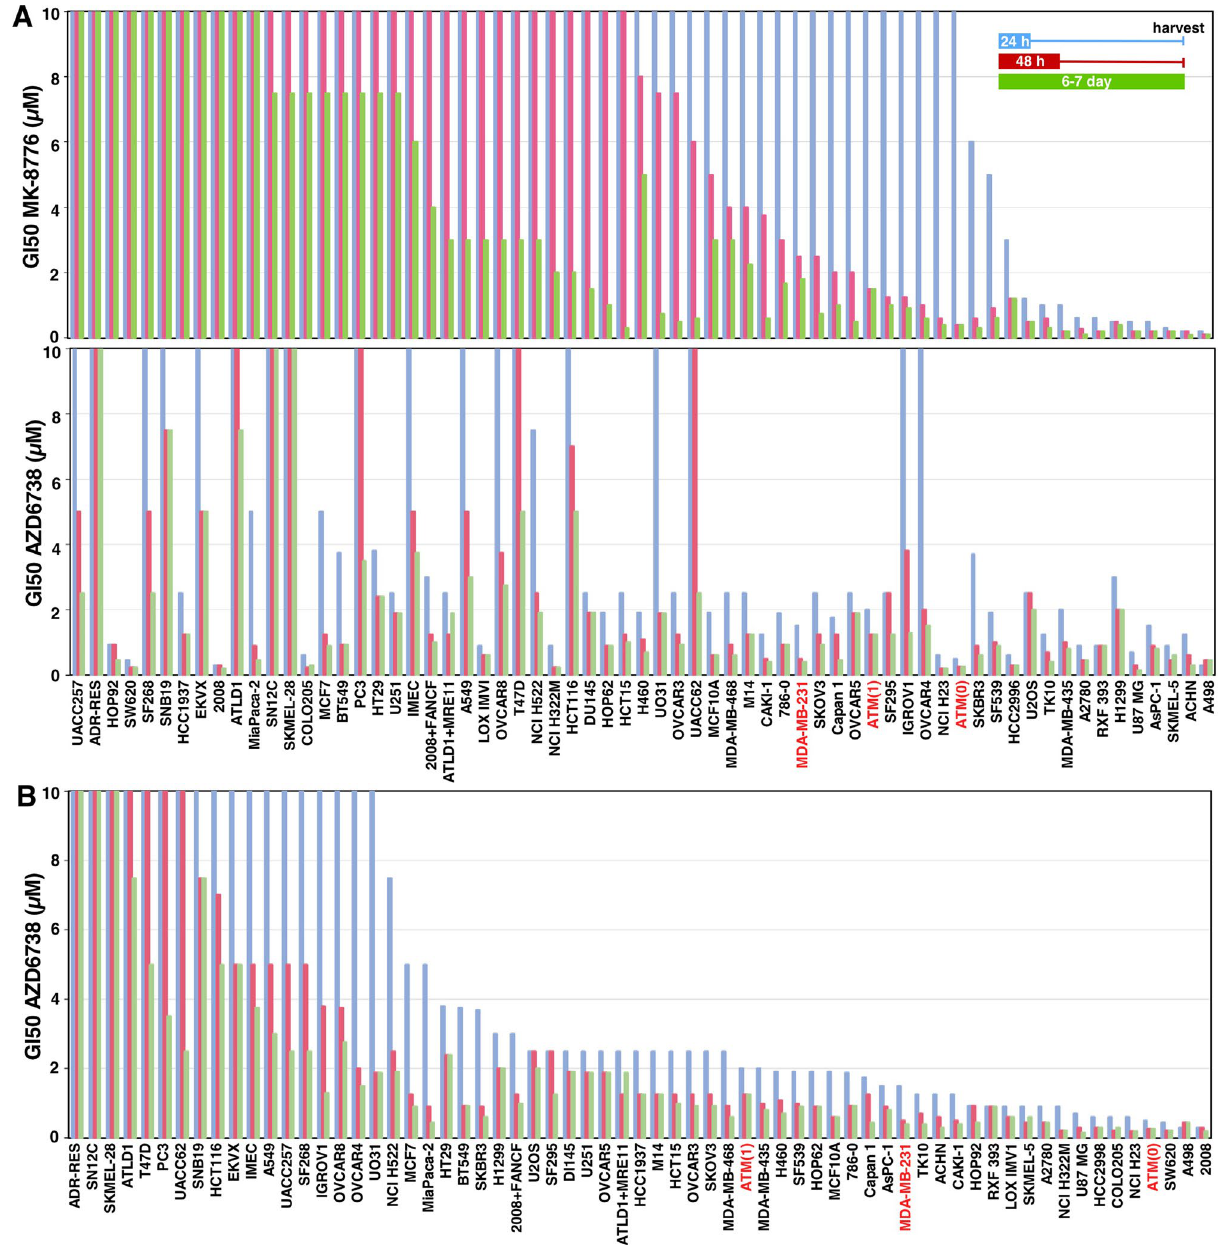
Figure 1. Sensitivity of cell lines to MK-8776 and AZD6738. ( A ) Each cell line was incubated with MK-8776 (top) or AZD6738 (bottom) for either 24 h or 48 h, then drug was removed, and cells were incubated in fresh media for an additional 5–6 days. Alternately, cells were incubated in drug continuously for 6–7 days. Cells were lysed in the well, stained with Hoechst 33258, and the concentration that inhibited growth by 50% was recorded. Cell lines in both panels are sorted by sensitivity to MK-8776. The panel for MK-8776 is updated from our prior paper 5 . ( B ) Results for AZD6738 from A are resorted in order of sensitivity to AZD6738. The cell lines highlighted in red are MDA-MB-231 and its ATM-dysfunctional derivatives discussed